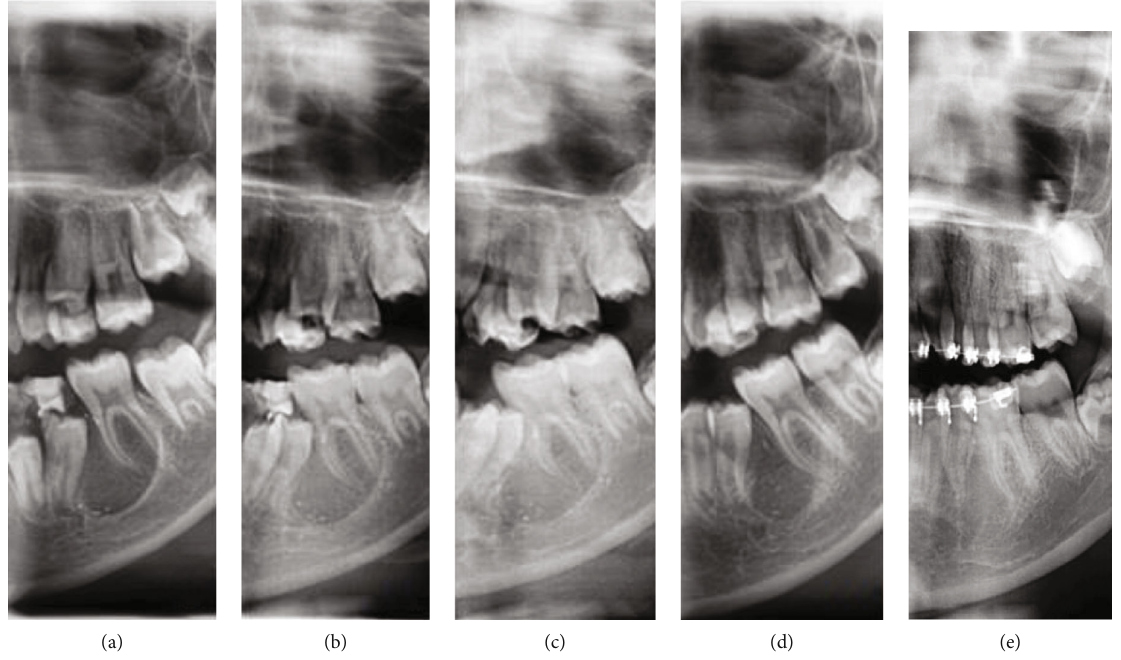
Figure 2: shows panoramic radiographs taken at initial and subsequent follow-up visits (a). The preoperative imaging referred by the orthodontist. (b) The lesion one-month post-intervention (c) At 3-month follow-up post-intervention. (d) At nine-month follow-up. (e) At 18 months of follow-up post-intervention showing complete resolution. Table 1: the full biochemistry panel of the patient before, after the medical intervention, and eighteen-month follow-up values. At Six weeks post-medical Nine months post-medical Eighteen months post-medical Range value presentation intervention intervention intervention 81.3 49.3